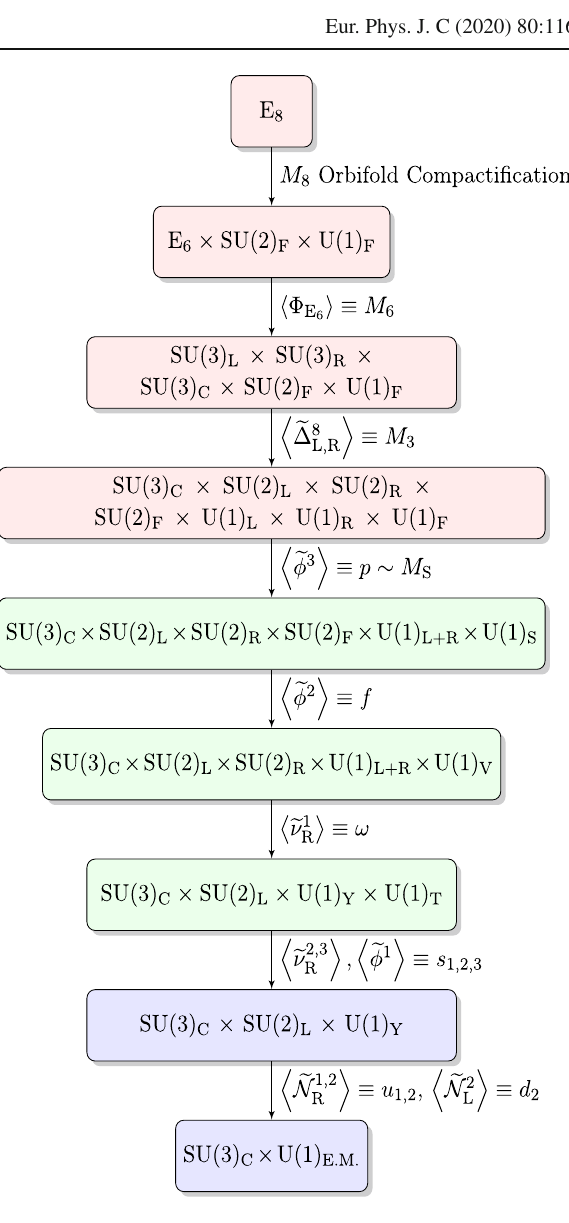
Fig. 1 The gauge symmetry breaking scheme considered in this work. In the red blocks SUSY is approximately unbroken while in the green ones it is softly broken. The blue blocks represent the SM gauge sym- metry and below with only the lightest states included. The ˜ ν 2 , 3